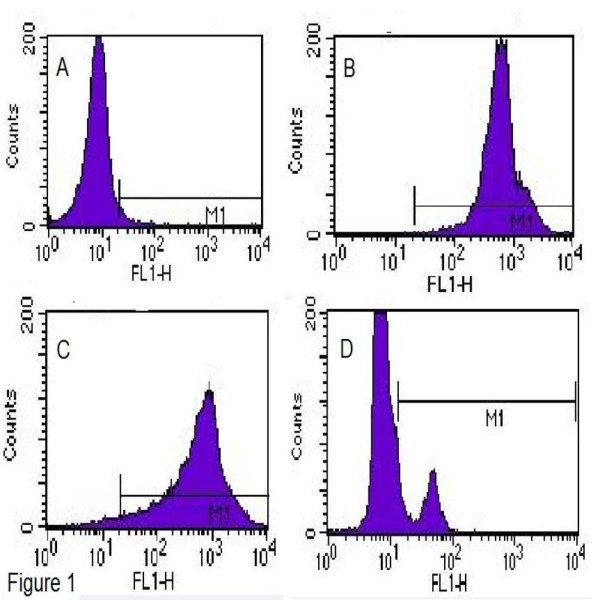
Phenotype of adherent bovine monocytes. The adherent monocytes were stained with MHCI, MHCII or CD14 primary antibodies followed by FITC-labeled secondary antibody. The experiments were repeated three times and mean expressions were calculated. A) Mean of secondary antibody control showing 2.03 ± 0.7% stained cells; B) Cells showing mean MHCI expression as 96.62 ± 0.5%; C) Cells showing mean MHCII expression as 80.58 ± 19.7%; and D) Cells showing mean CD14 expression as16.54 ± 1.5%.